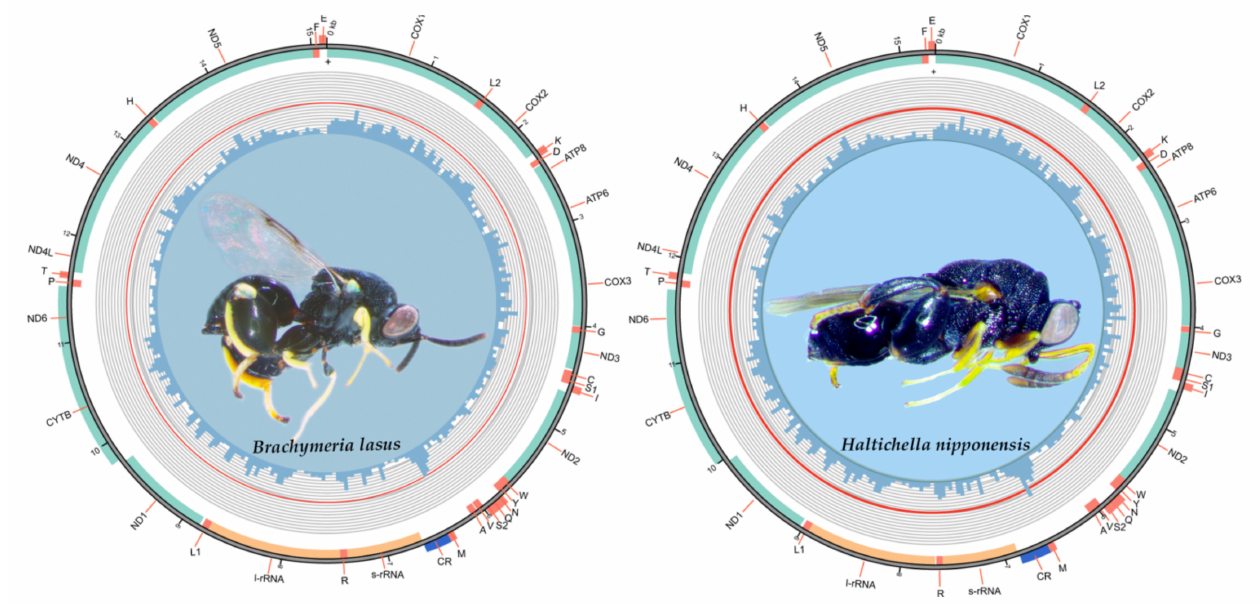
Figure 1. Complete mitochondrial genomes of B. lasus and H. nipponensis . The inner circle indicates the GC content in every 50-site window, and the outer circle shows the arrangement of the genes: light green for the PCGs, salmon for tRNAs, orange for rRNAs, and blue for control